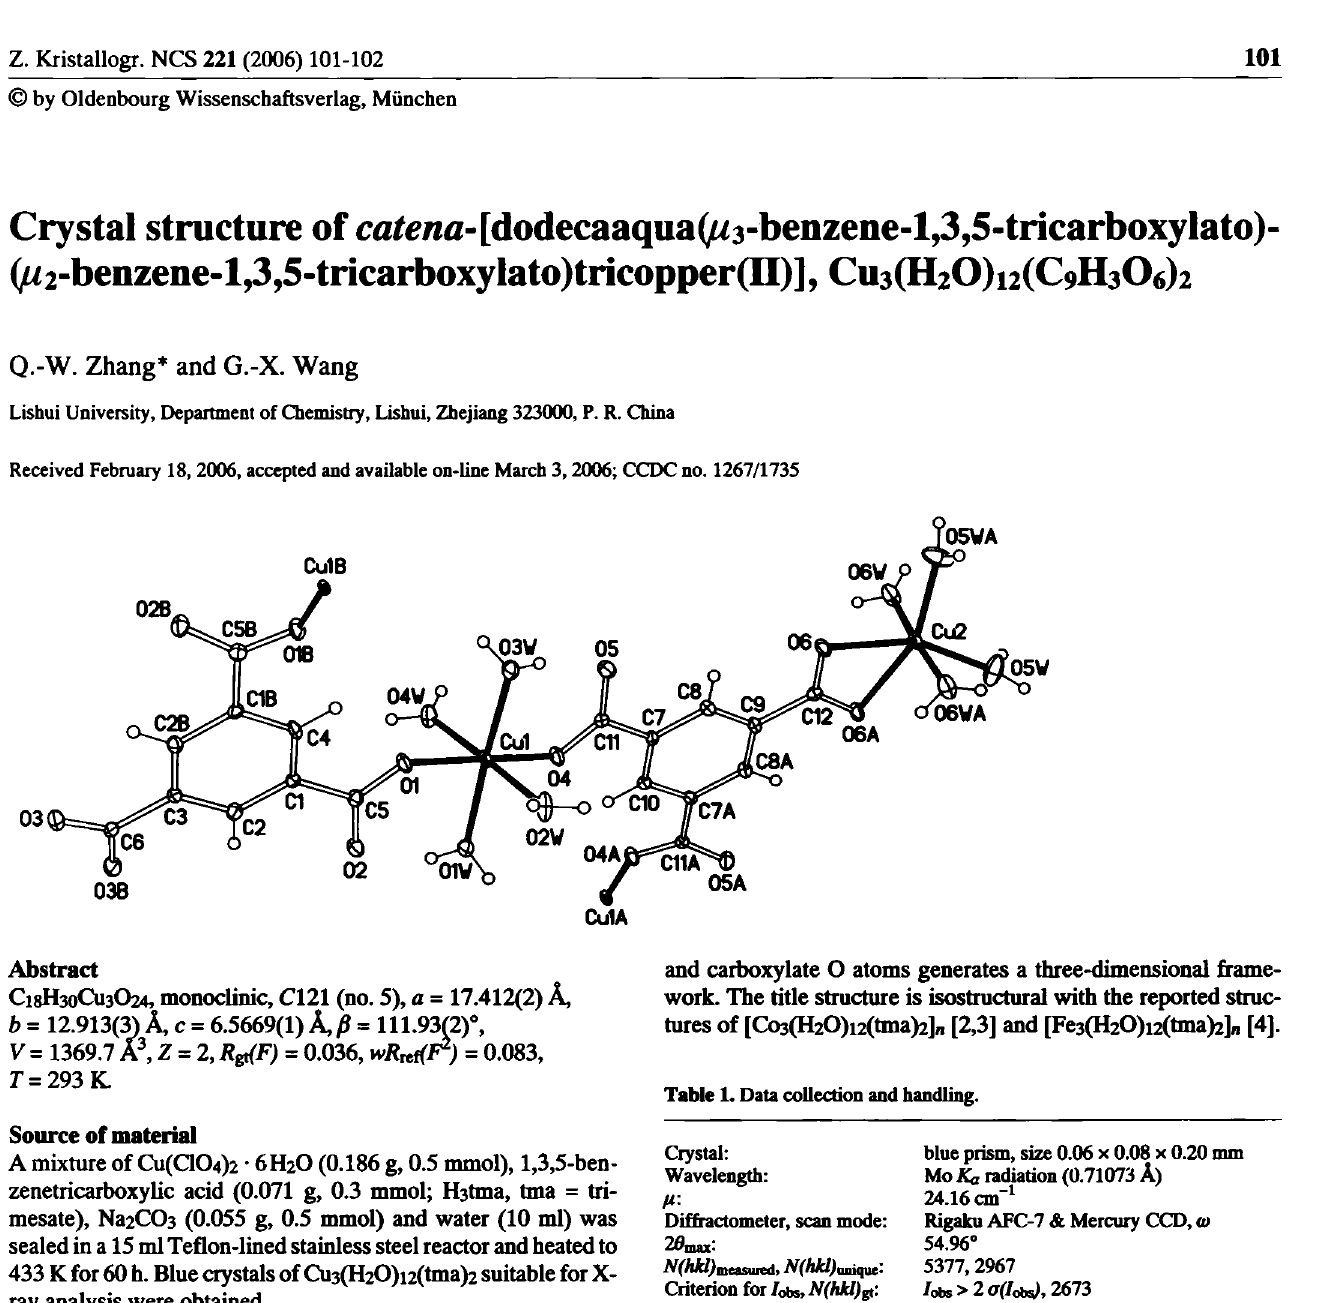
Table 2. Atomic coordinates and displacement parameters (in A 2